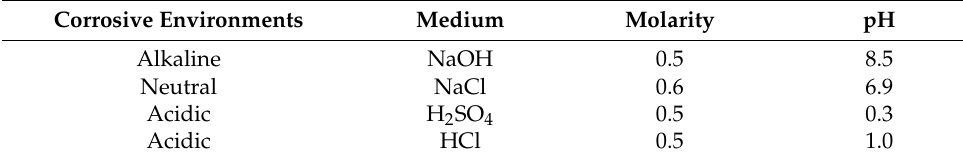
Table 1. Different corrosive media used for electrochemical corrosion experiment.